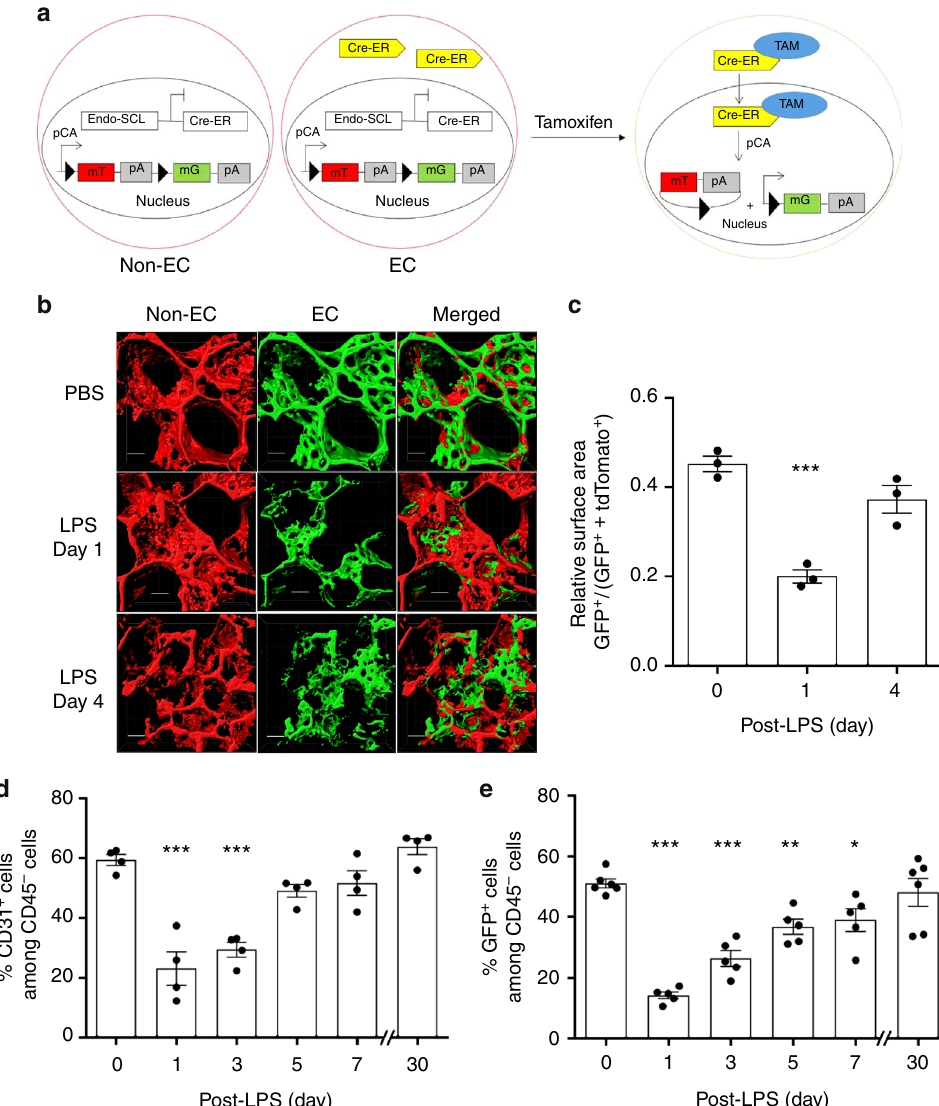
Fig. 1 Lineage tracing analysis of lung EC injury induced by endotoxemia and kinetics of regeneration. a We carried out studies to establish a model of endotoxemia (LPS) induced EC injury in lungs followed by progressive recovery of endothelium. Studies were made in mTmG double fl uorescent